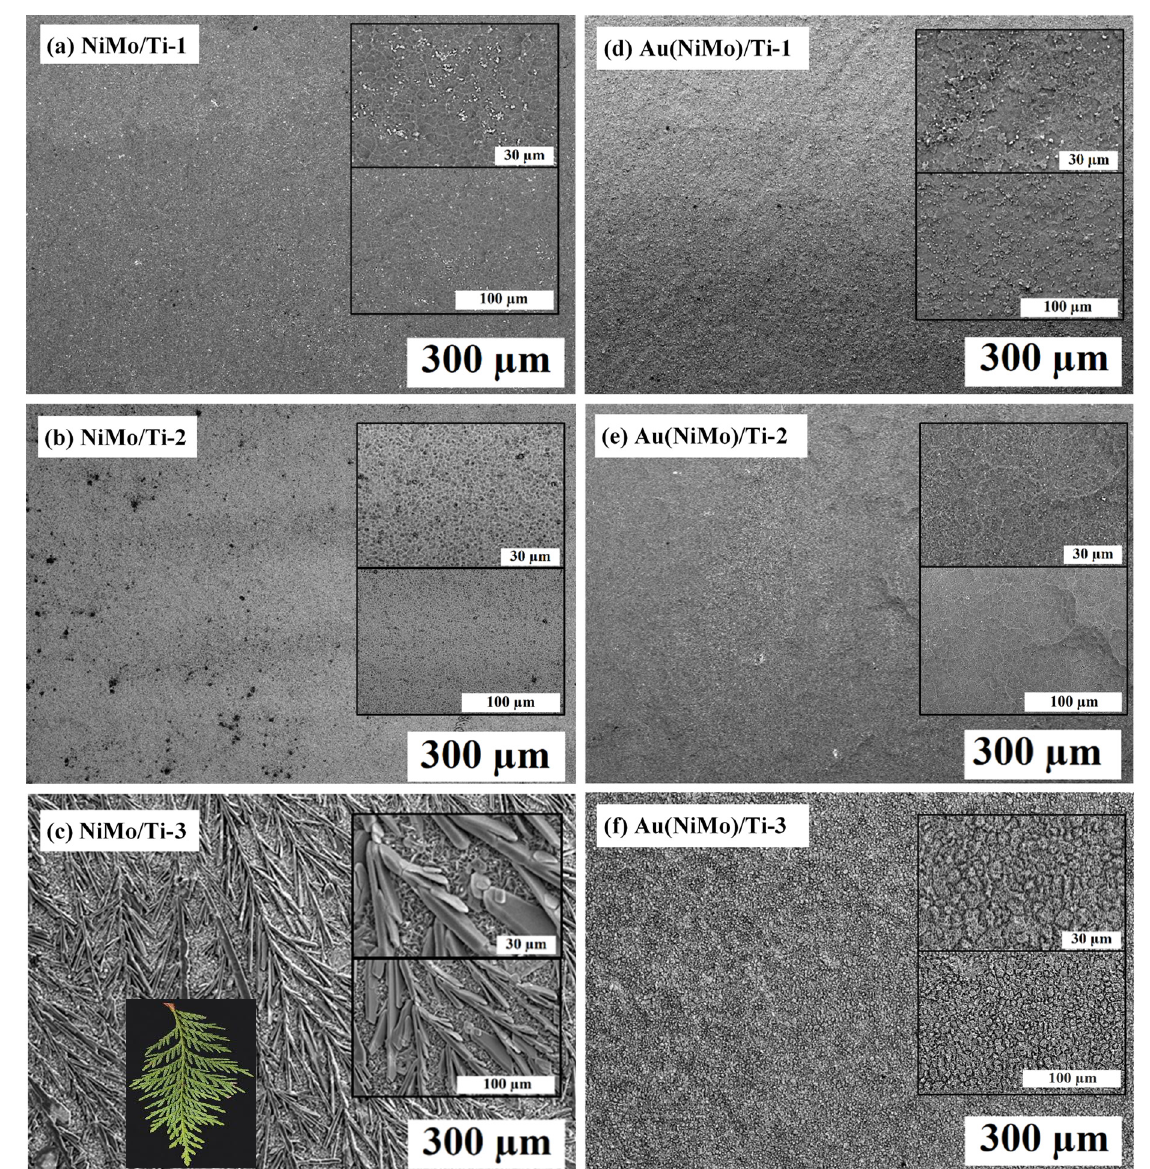
Figure 1 . SEM views of NiMo/Ti ( a – c ) and Au(NiMo)/Ti ( d – f ) catalysts mentioned in Table 2. ( c ) The inset represents a photo of a cedar leaf .